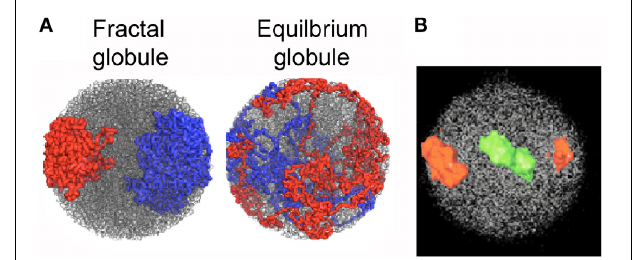
FIGURE 5 | Chromosome territories. (A) Simulation of two polymer chains compacted into a fractal globule shows a territorial organization like that of chromosomes 18 and 19 in a human lymphocyte nucleus (B) , whereas they are mixed in an equilibrium globule. (A) reproduced from [58], (B) reproduced from [22] by permission from Macmillan Publishers Ltd, © 2001.